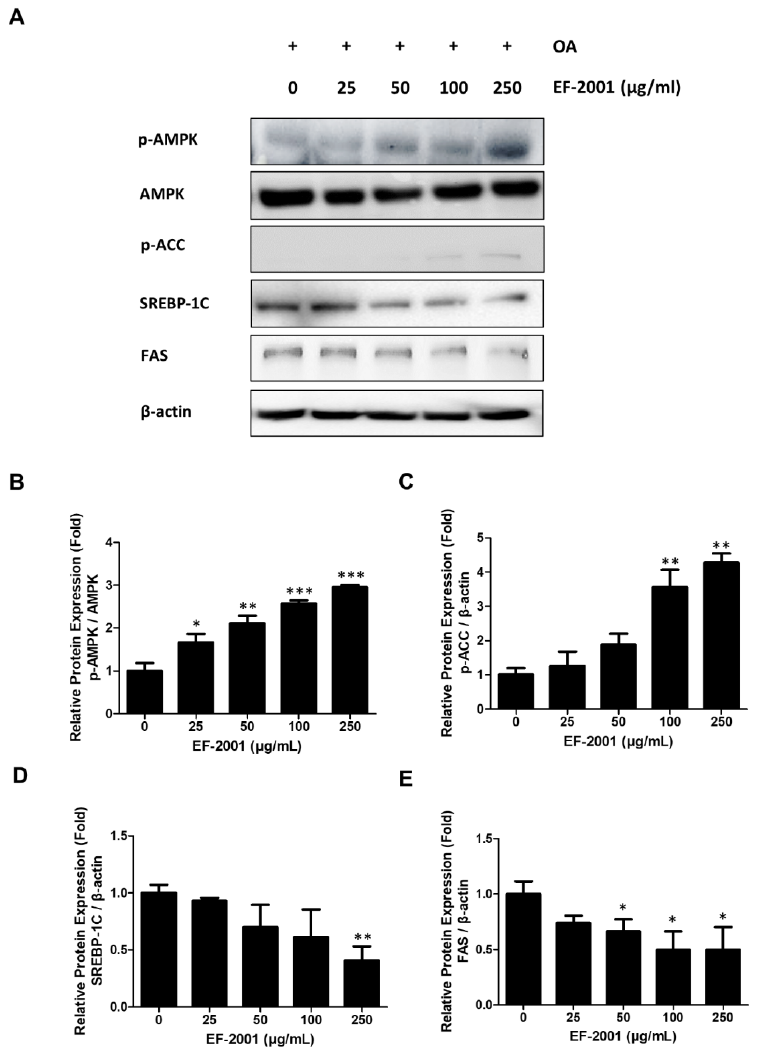
Figure 5. Effects of EF-2001 on AMP-activated protein kinase (AMPK) signaling pathways in FL83B hepatocytes. FL83B hepatocytes were treated with 0.5 mM oleic acid (OA) for 48 h to induce lipid accumulation. Media was changed in the absence or presence of various doses of EF-2001. Cells were harvested at the time at which the expression of each AMPK signaling protein was induced, and Western blotting was performed to determine the expression levels of ( A ). The relative protein expression levels of p-AMPK ( B ), p-ACC ( C ), SREBP-1C ( D ), and FAS ( E ) are shown in parts, respectively. Data are represented as mean ± SEM. ( n = 3); * p < 0.05, ** p < 0.01, and *** p < 0.001 vs. control.